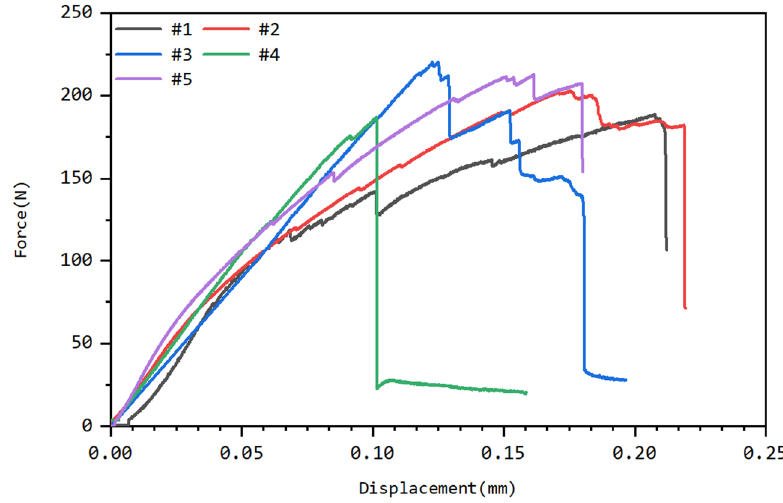
Figure 9. Experimental force-deformation graphs for composite material under three-point bending Figure 9. test.